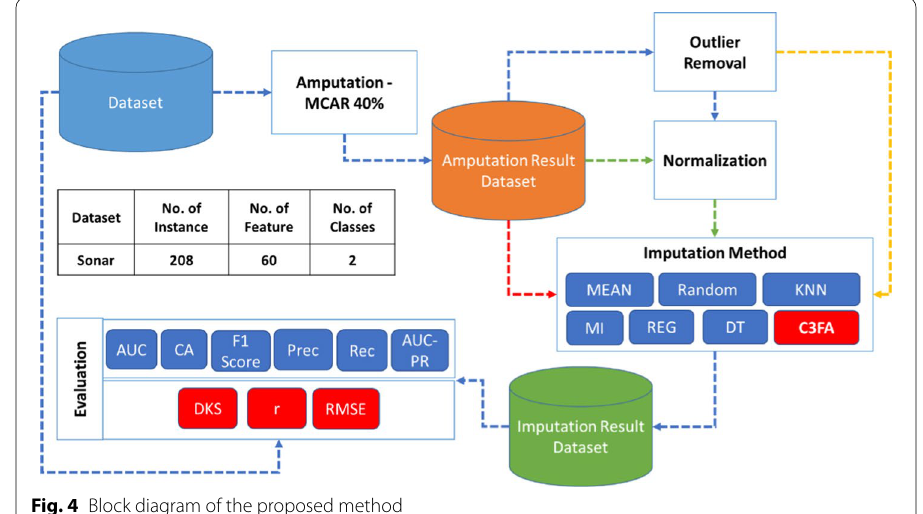
Fig. 4 Block diagram of the proposed